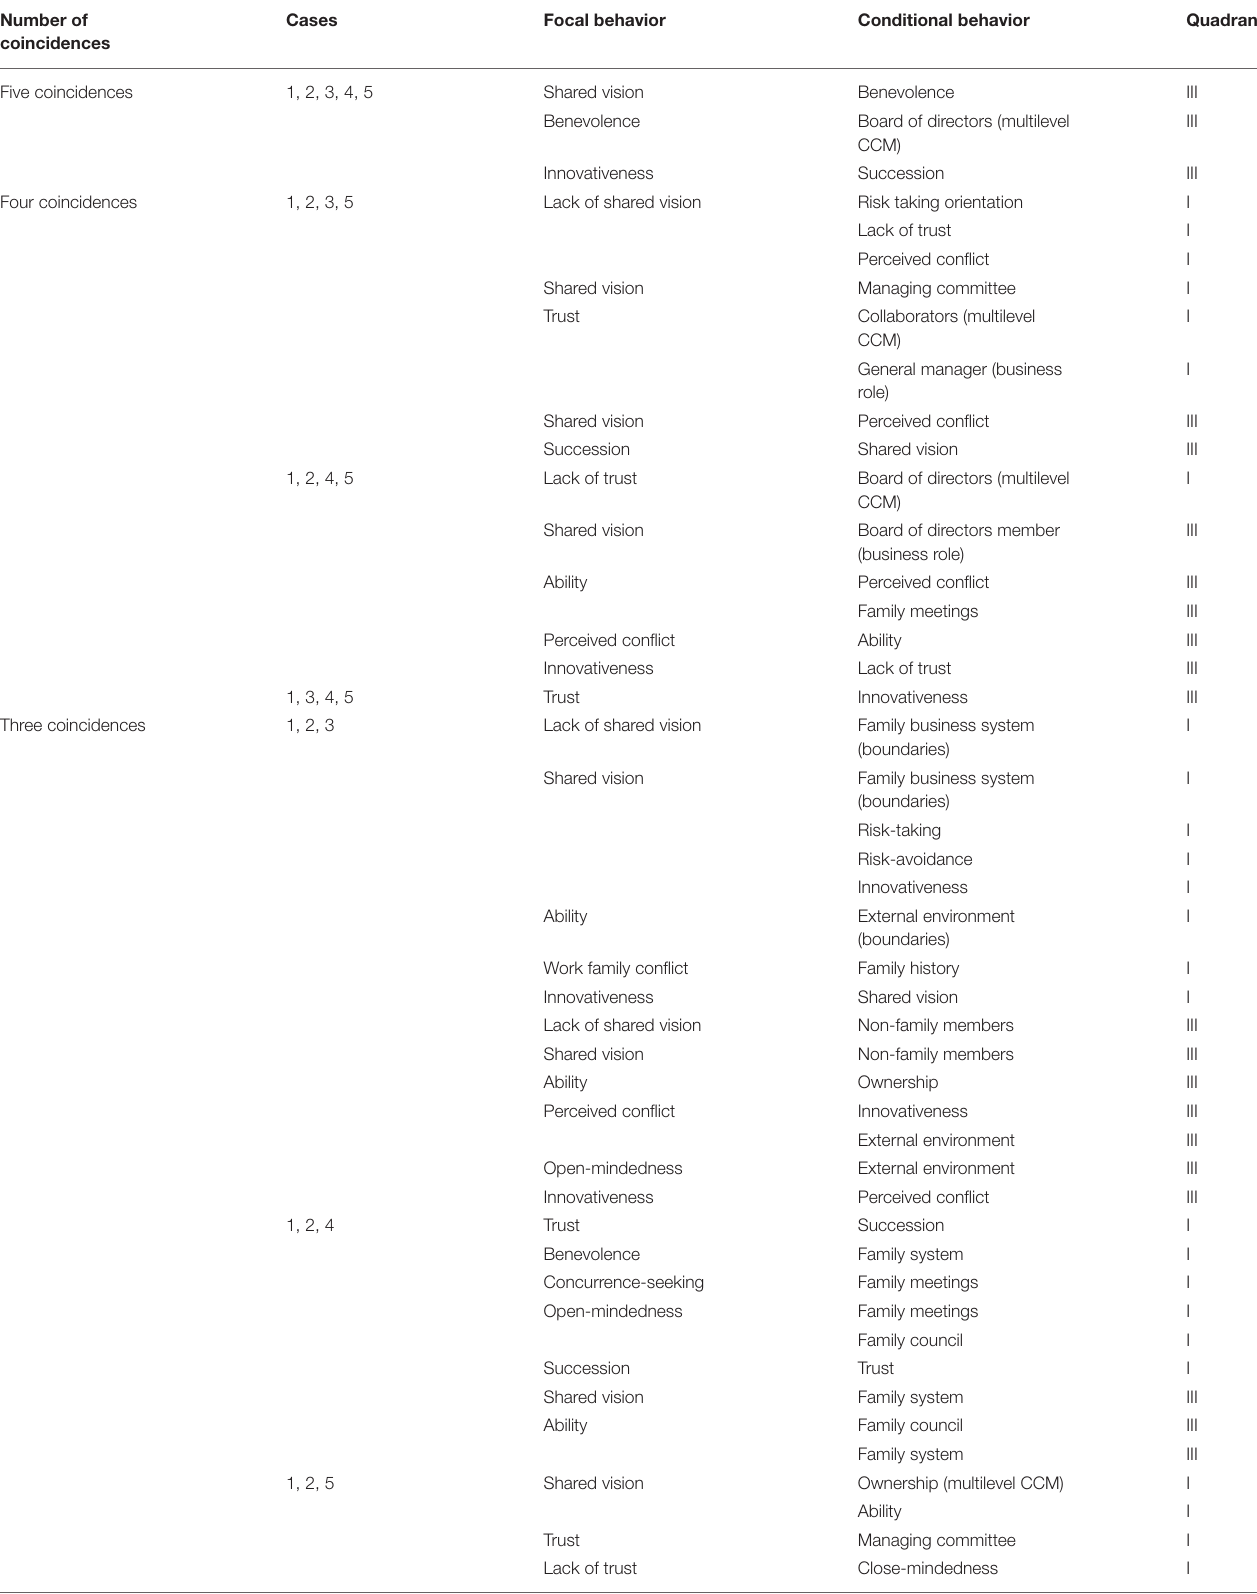
TABLE 6 | Patterns of coincidence in terms of their associative relationships across the five cases studied. Number of